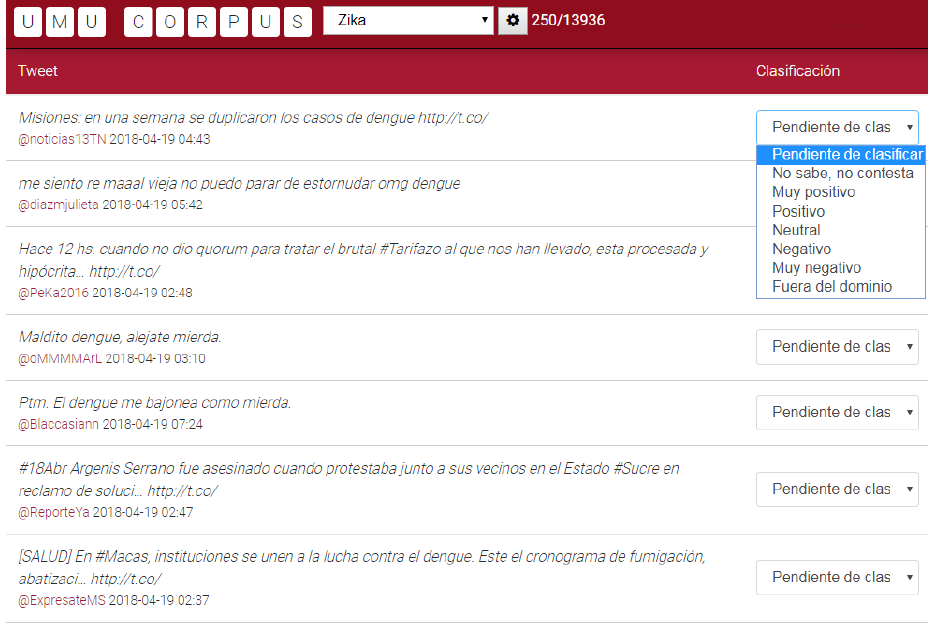
Figure 3. Screen-capture of the corpus classifier tool with some examples of